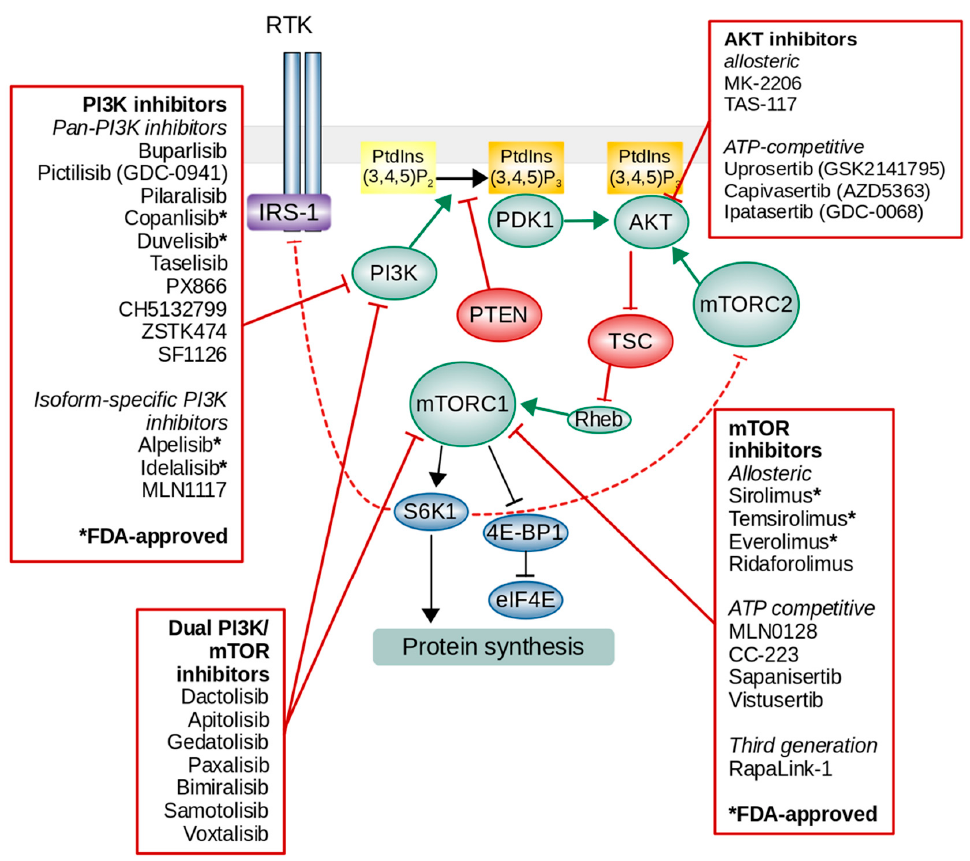
Figure 2. The overview of phosphatidylinositol-3-kinase (PI3K)/AKT/mTOR signaling pathway and inhibitors.